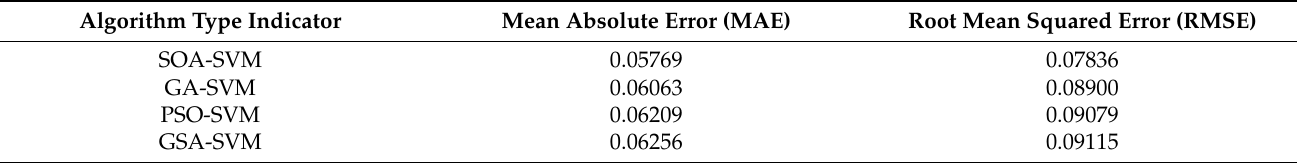
Table 4. The prediction error of the test set by different